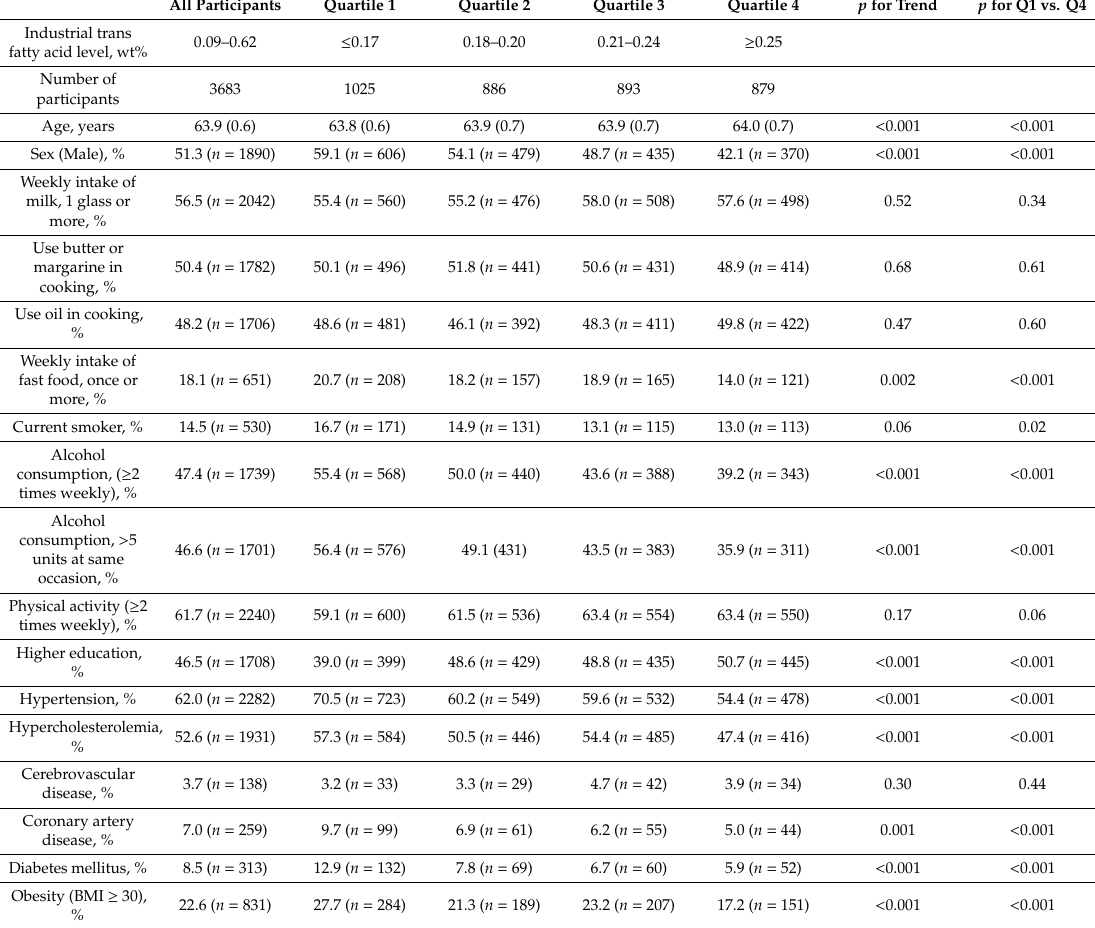
Table 1. Characteristics of participants according to quartiles of industrial trans fatty acid